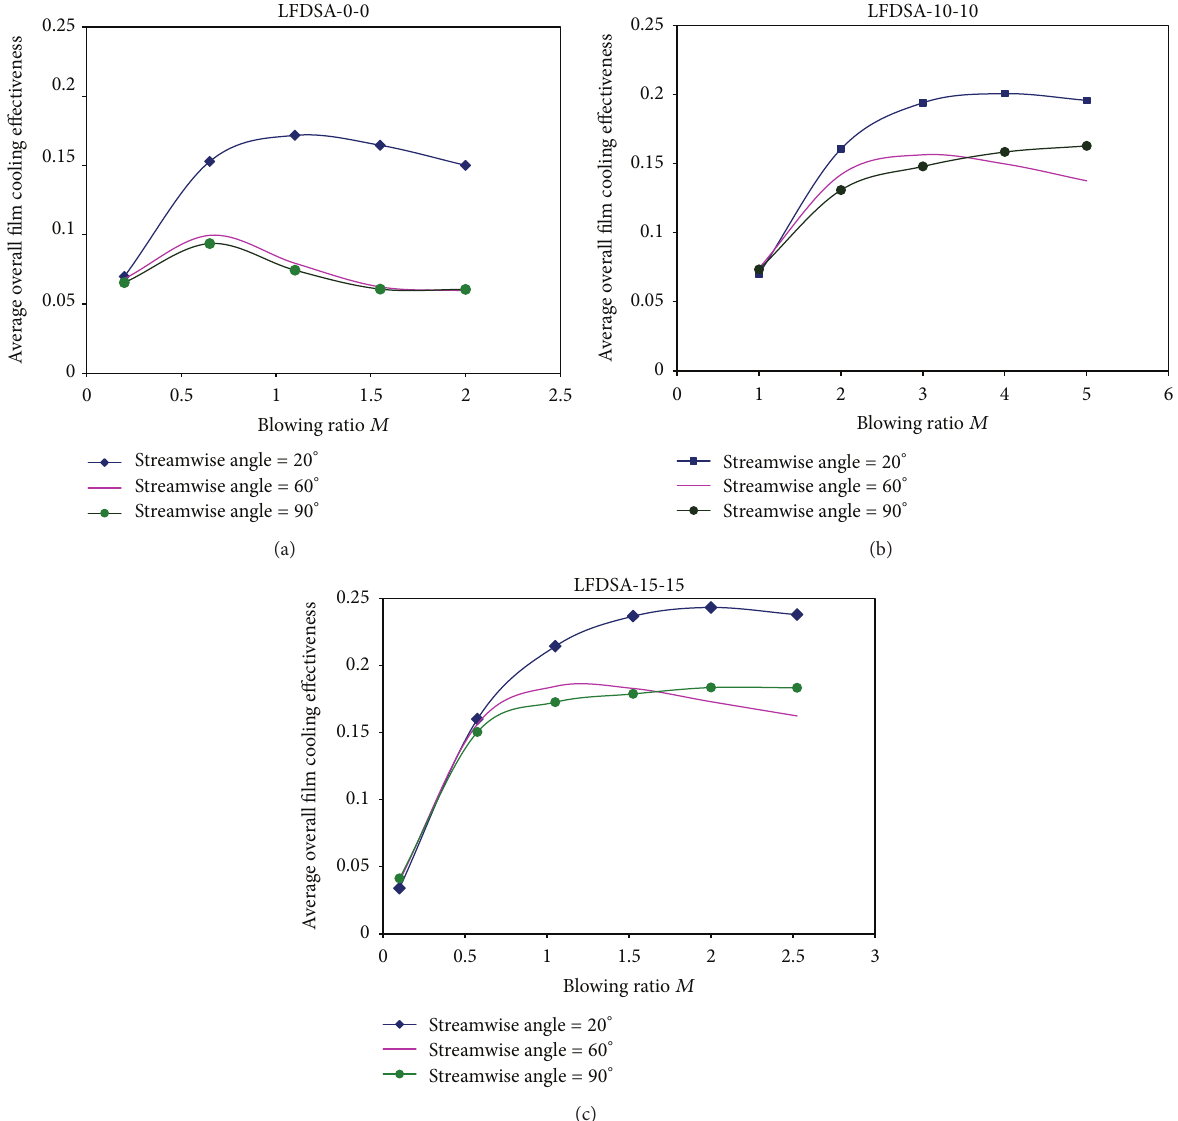
Figure 30: Average overall film cooling effectiveness versus blowing ratio for different streamwise angles of different hole shapes.